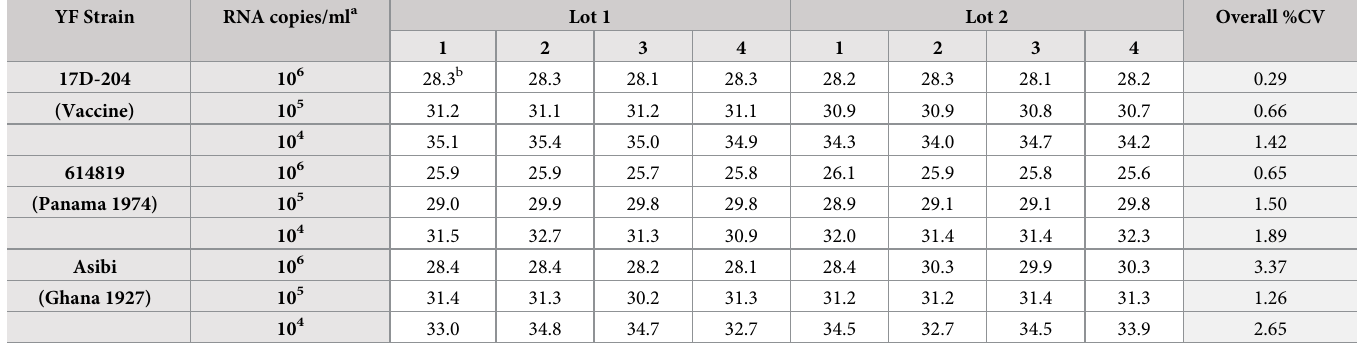
YF, yellow fever; RNA, ribonucleic acid; %CV, coefficient of variation. a Approximate RNA copies/ml b Cycle threshold (Ct)